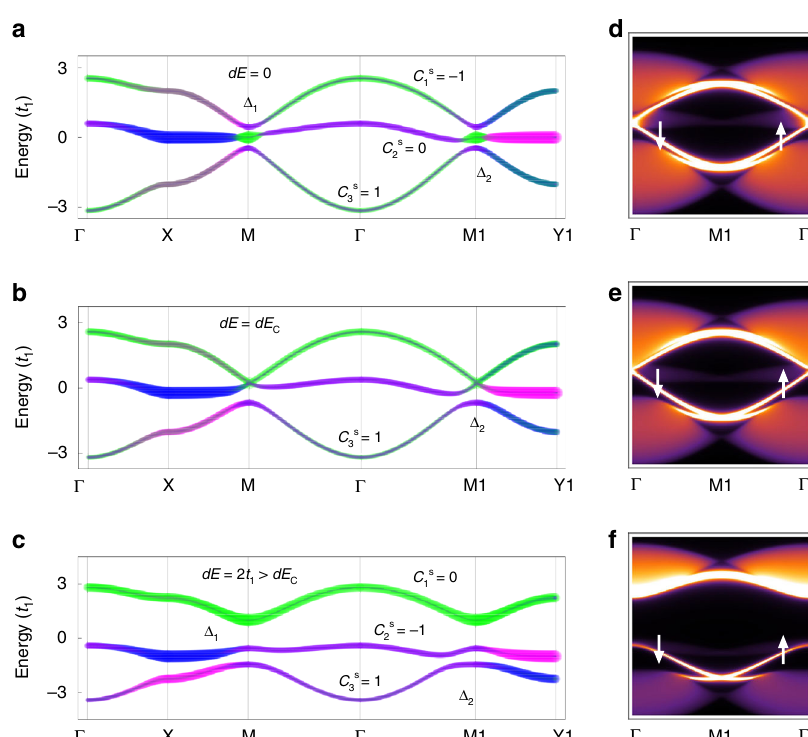
Fig. 2 Distorted Lieb lattice models with SOC effects. a – c Calculated band structures of distorted Lieb lattices with SOC effects ( λ = 0.1 t 1 ). TB parameters of distorted Lieb lattice are adopted from Fig. 1g but with variable dE : ( a ) dE = 0 < dE c , ( b ) dE = dE c , and ( c ) dE = 2 t 1 > dE c . dE